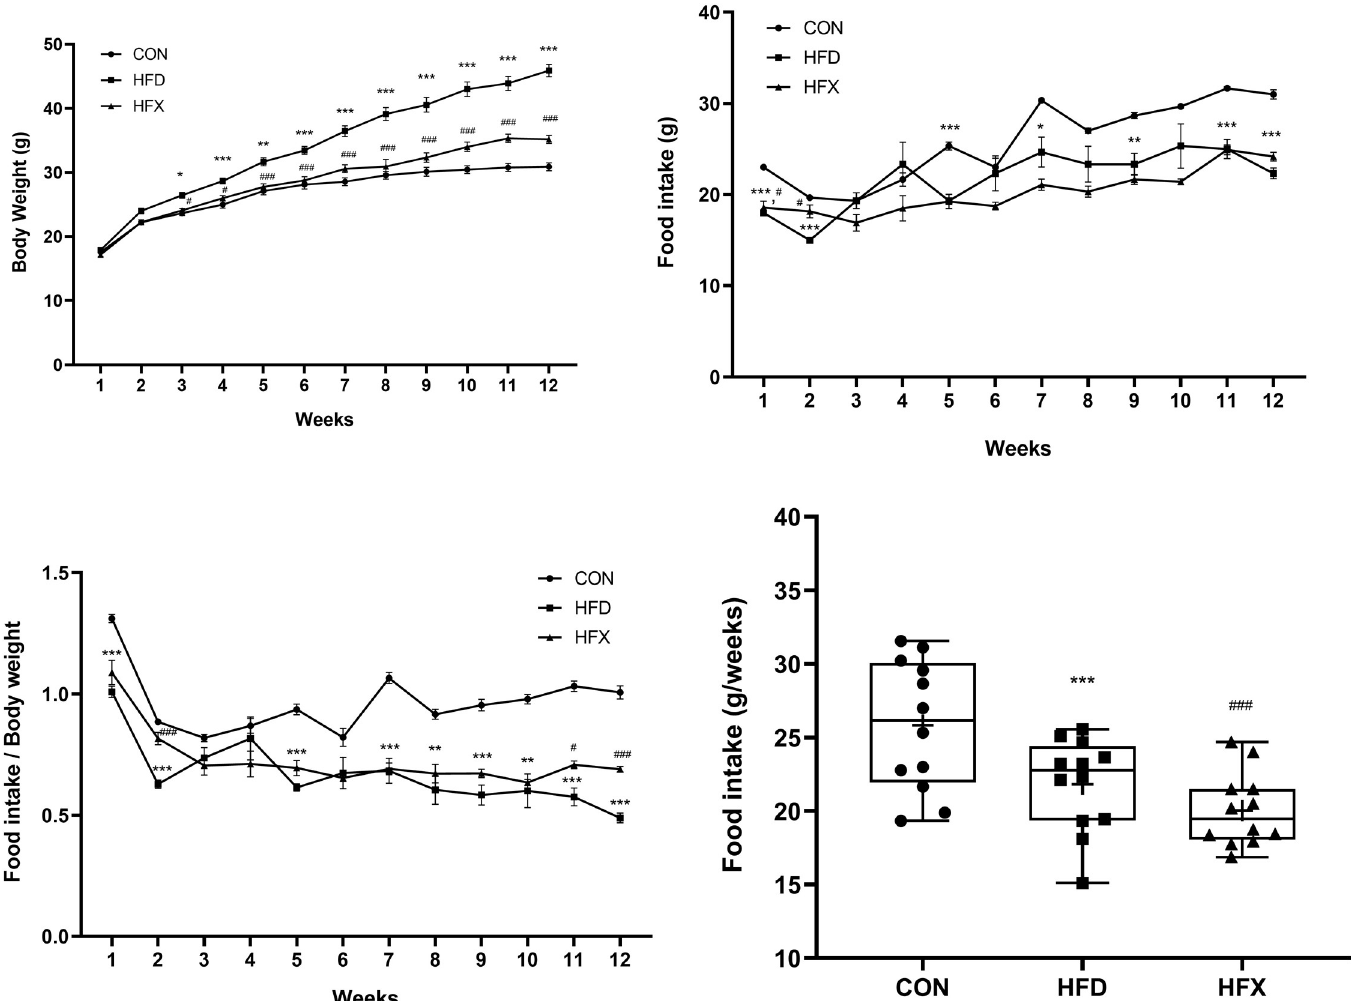
Fig 1. The effects of a high-fat diet and voluntary wheel running (VWR) on body weight, food intake. C57BL/6 mice were fed a high-fat diet (HFD), a high-fat fed with VWR (HFX), and corresponding control diet (CON) for 12 weeks. (A) The body weight curve of the CON, HFD, and HFX group was monitored. (B) Weekly food intake of the CON, HFD, and HFX group for 12 weeks. (C) The ratio of weekly average food intake to body weight for all experimental groups. (D) Distribution of food intake for all experimental groups. The data represent means ± SEM of (A-D) n = 9, the control group (CON); n = 9, the high-fat diet group (HFD); n = 12, the high-fat diet VWR group (HFX). �� P < 0.01, ��� P < 0.001 compared with CON and ## P < 0.01, ### P < 0.001 compared with HFD, using two-way ANOVA with Tukey-Kramer post-hoc test with a standard significance threshold (P < 0.05)